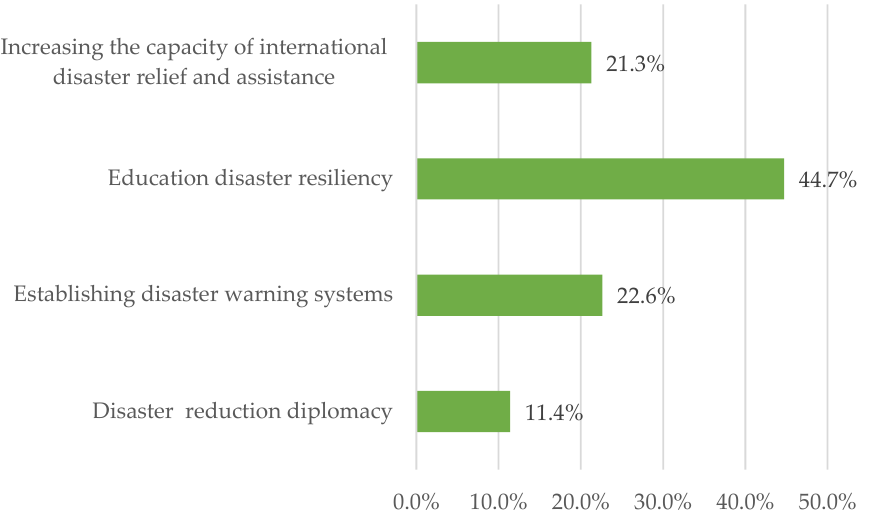
Figure 2. Key focus areas of governance in developing disaster resiliency. Source: Authors ’ own work (2022).